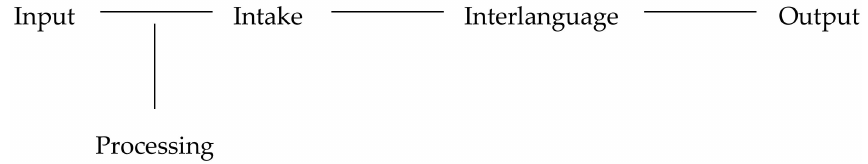
Figure 7. Process of language acquisition